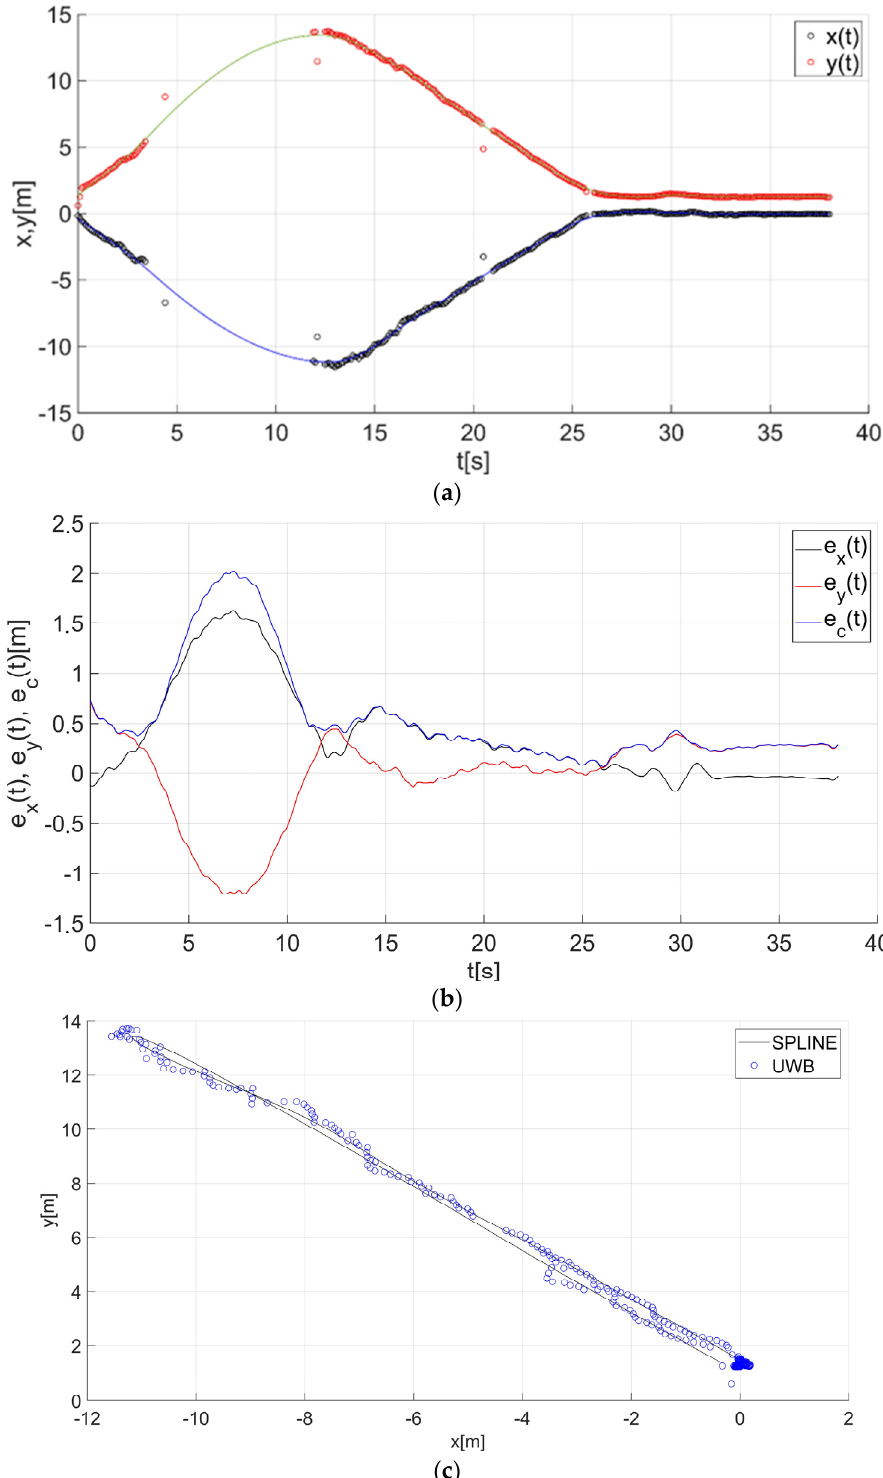
Figure 15. Results for the estimation of guide path no. 3 with the use of the smoothing spline: ( a ) the course of the guide’s location coordinates x(t), y(t) with their continuous estimates, ( b ) the course of the estimated location errors e x (t), e y (t), e c (t), ( c ) guide’s location along with the path estimation [6].